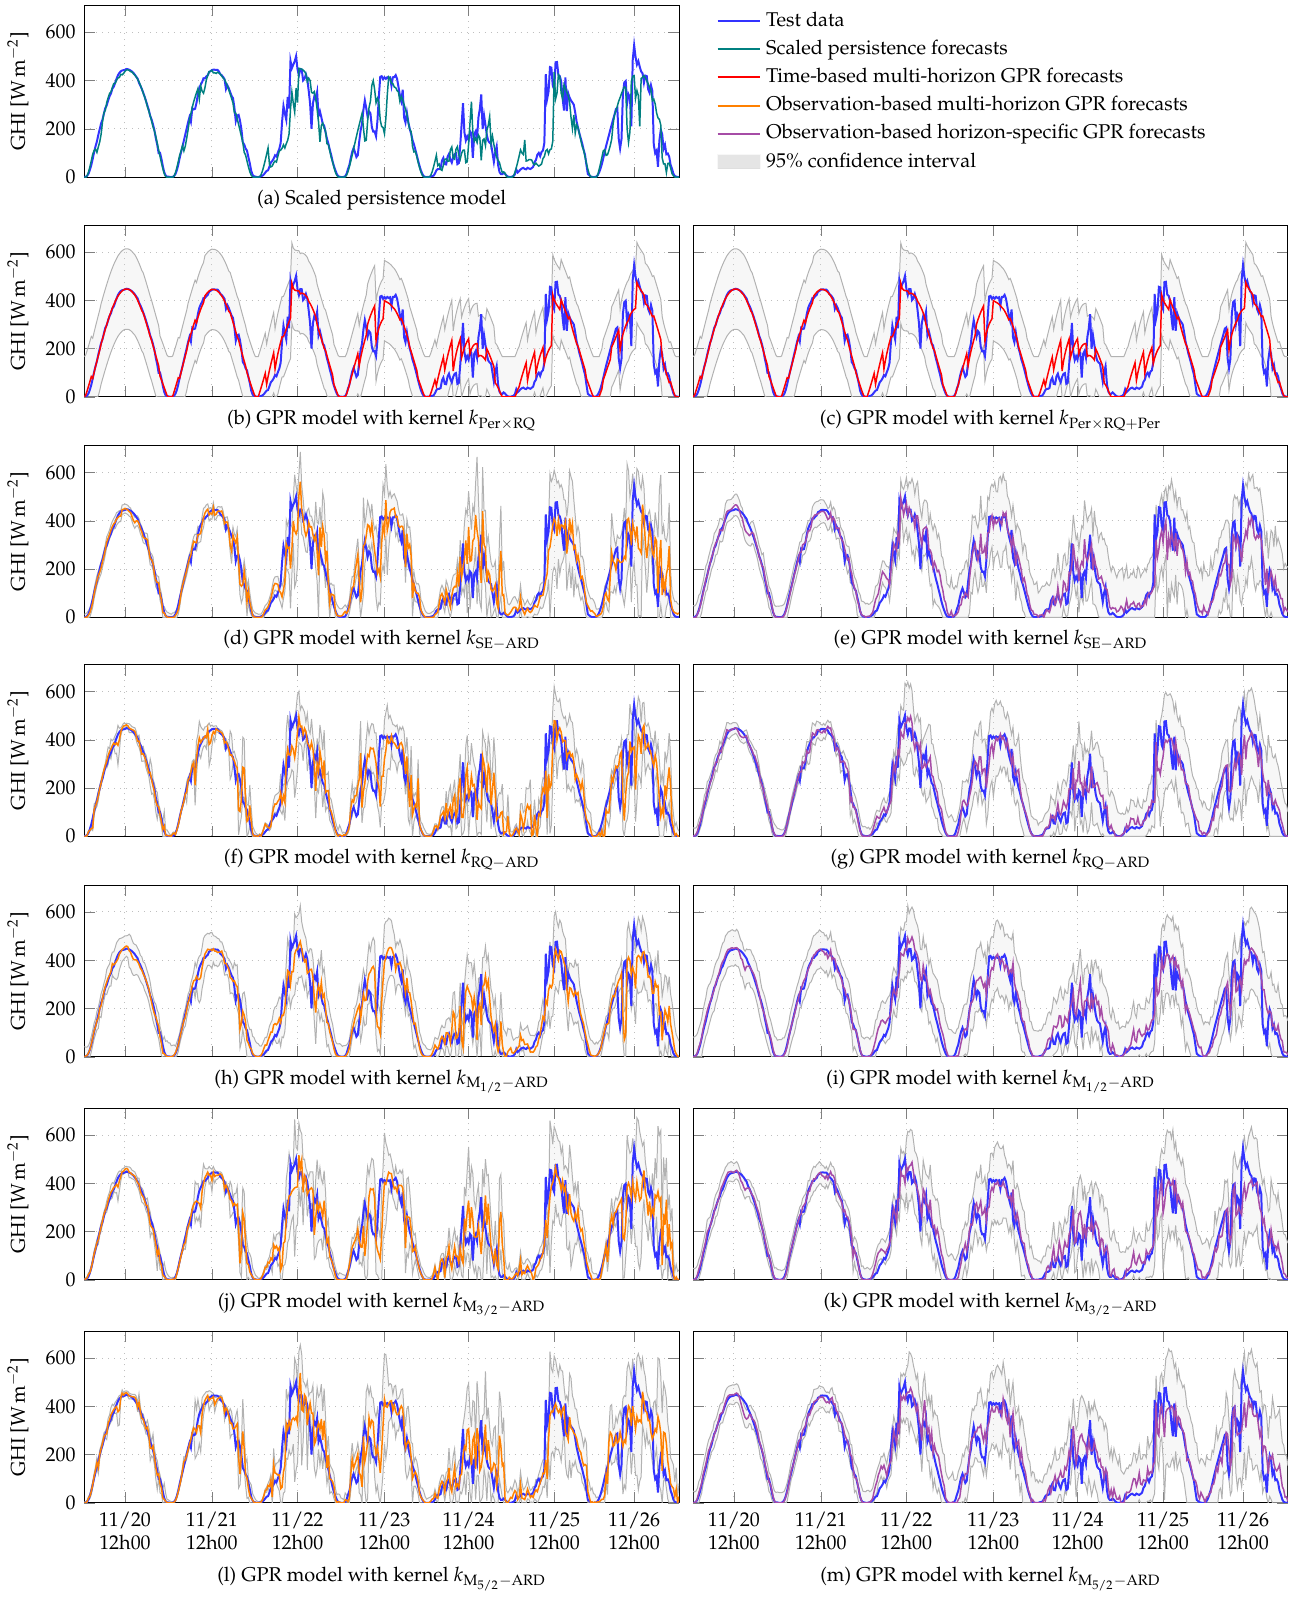
Figure 12. Examples of 1 h GHI forecasts over one week, given by the scaled persistence model and the GPR models included in this